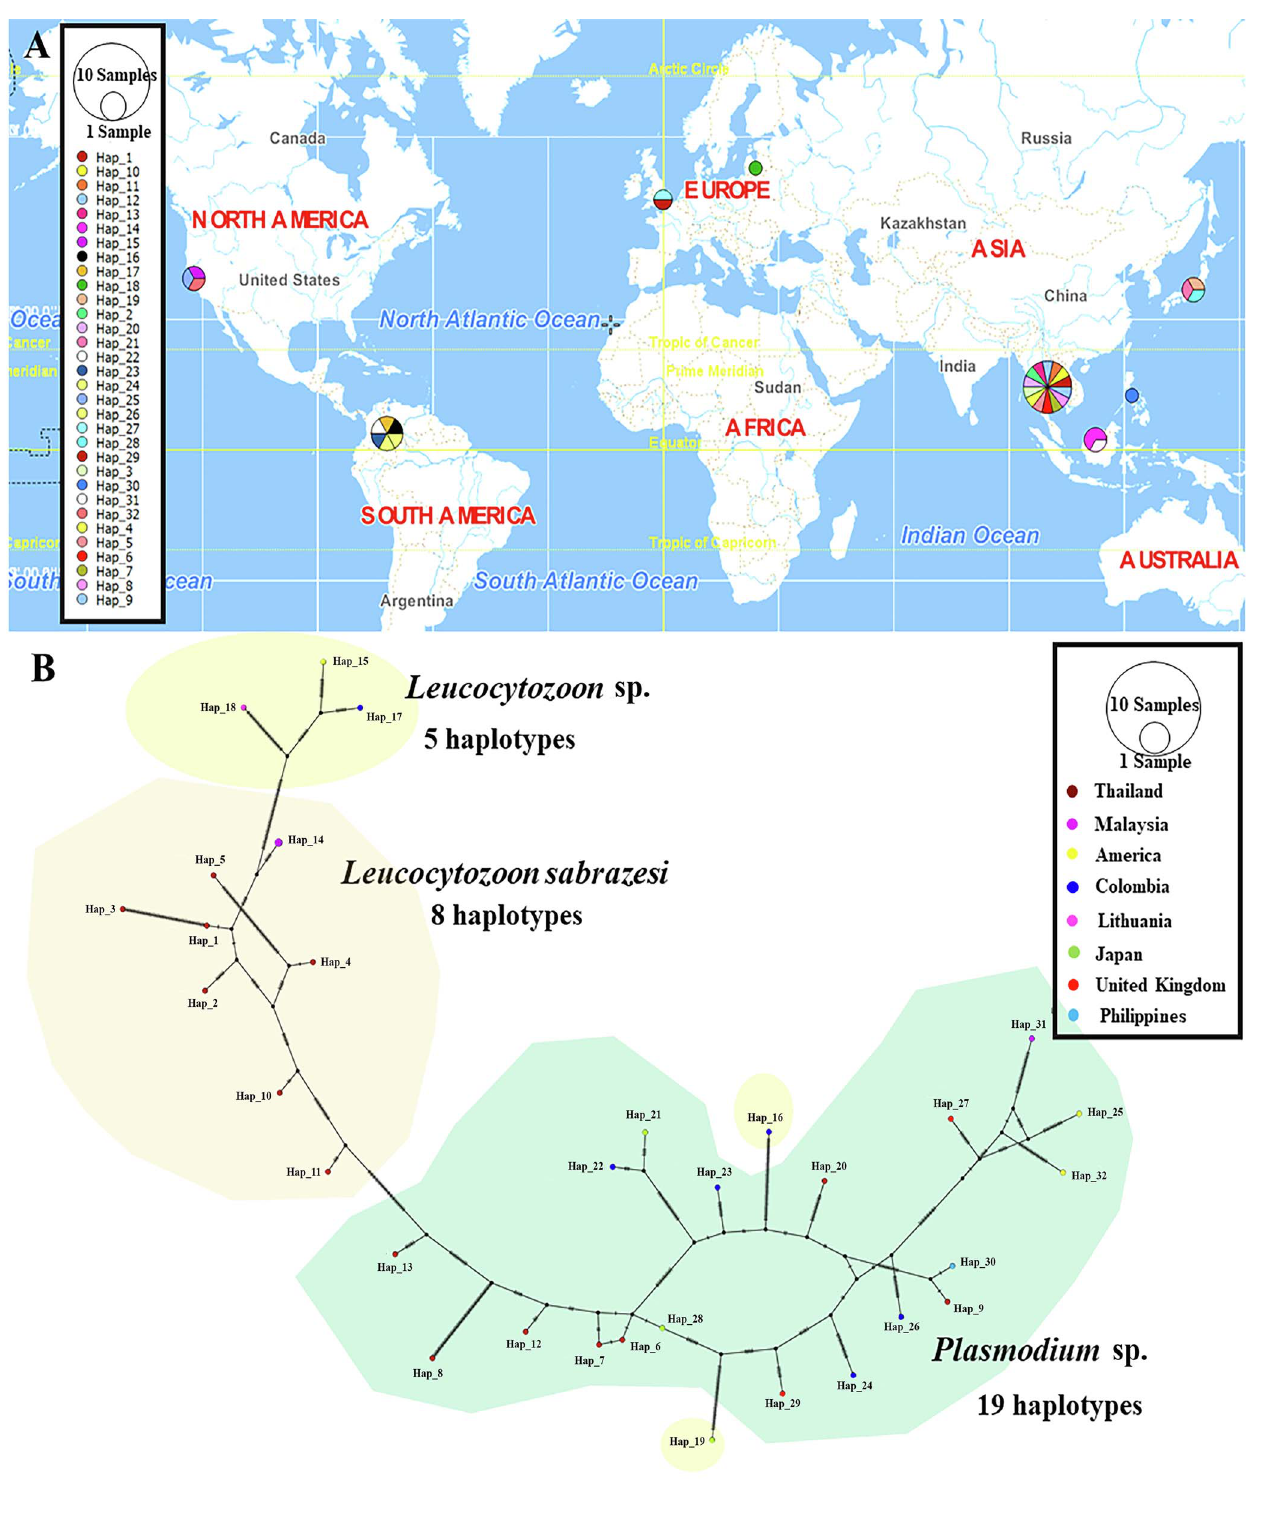
Fig. 8. TCS network of haplotypes based on Leucocytozoon spp. and Plasmodium spp. coxI gene sequences (A) detected in Thailand and other countries. The number of bars on lines between a haplotype and another represent the number of nucleotide mutation